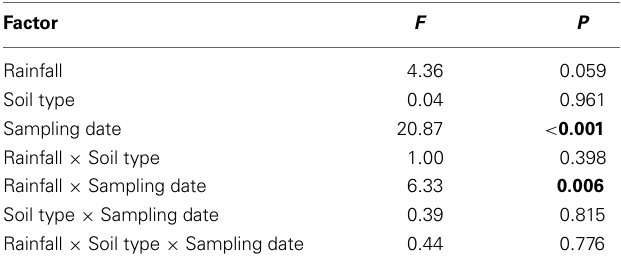
significantly affected the relative abundance of rare individuals ( P = 0 . 010). Hemiptera showed the highest relative abundance in all fields ( Figure 6 ). Rainfall variations and soil types had no effect on the diversity indices of arthropod communities (data not